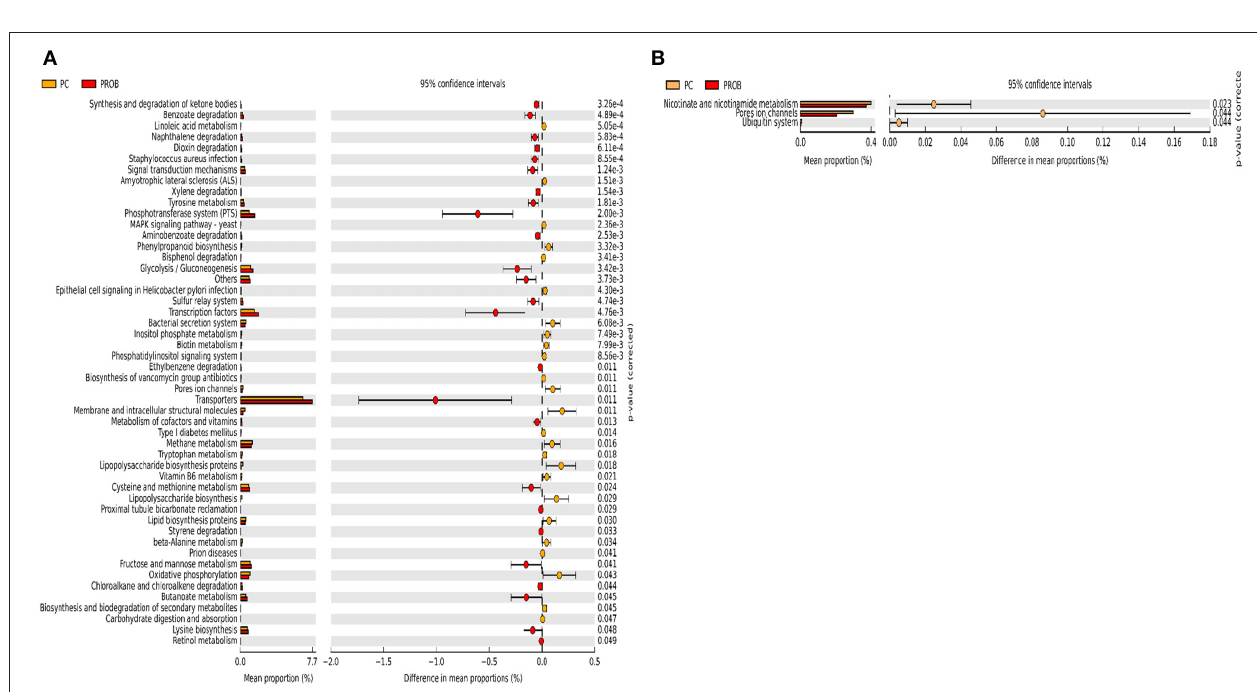
FIGURE 9 | Predicted functions of ileal mucosa microbiota in broiler chickens challenged with a subclinical naturally occurring necrotic enteritis at KEGG levels 3 ( n = 8/treatment). (A,B) Differentially regulated metabolic pathways in PC vs. PROB group on d 8 and d 42, respectively. PC (positive control): basal diet (corn-soybean meal) + 20g virginiamycin (453g Stafac ® 20)/ton diet; PROB (Probiotic): basal diet + 227g B. licheniformis spores/ton diet.